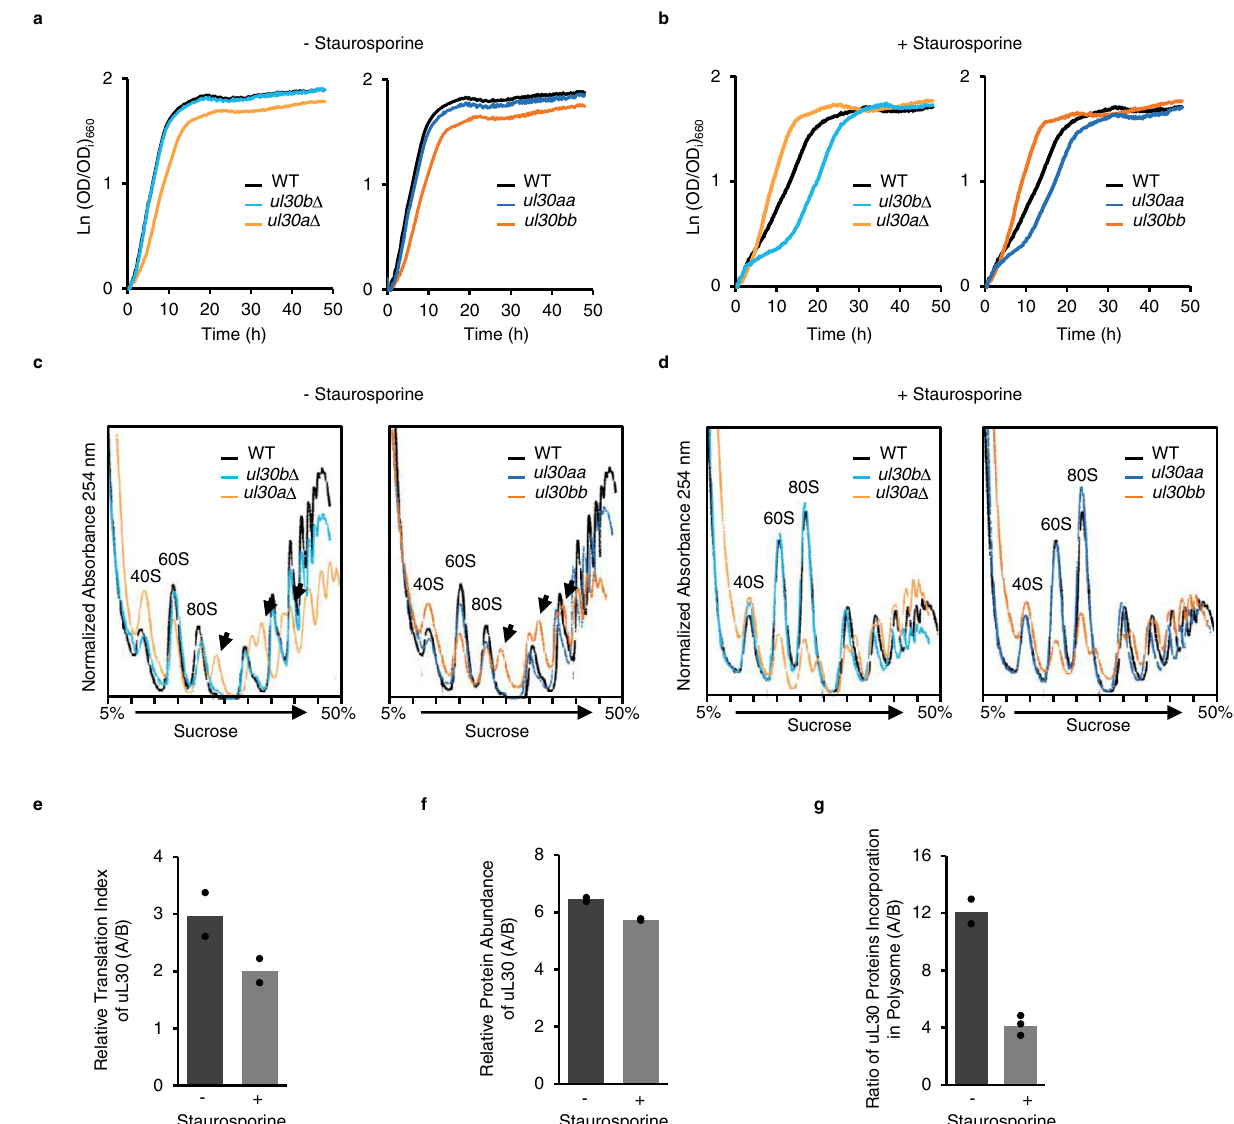
Fig. 2 | uL30 paralogs differentiallyalter cell growth, ribosome biogenesis and staurosporine resistance. a , b Growth curves of wild-type (WT), deletion strains ( ul30b Δ and ul30a Δ ) and homogenized strains ( ul30aa and ul30bb ) grown in complete synthetic media without ( a ) or in the presence of staurosporine ( b ). c , d Polysome pro fi les were obtained from WT, cells lacking one paralog or expressing two copies of the same paralog from cultures grown in complete syn- theticmediawithout( c )orinthepresenceofstaurosporine( d ).Positionof40Sand 60Sribosomalsubunitsand80Sribosomesareindicated.Arrowsindicateposition of half-mers or 40S awaiting the 60S subunit. Curves shown in ( a – d ) are repre- sentative examples from n =3 biologically independent biological samples. e Translation index (mRNA associated with polyribosomes/mRNA associated with